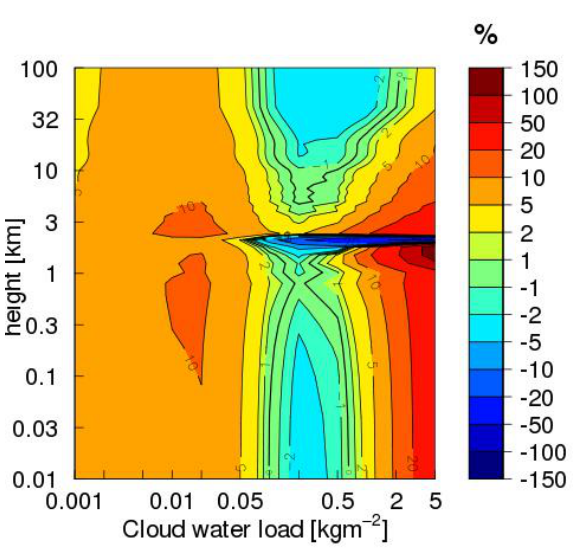
Figure 14. As for Fig. 11 but for hlradia vs. HS-DISORT.